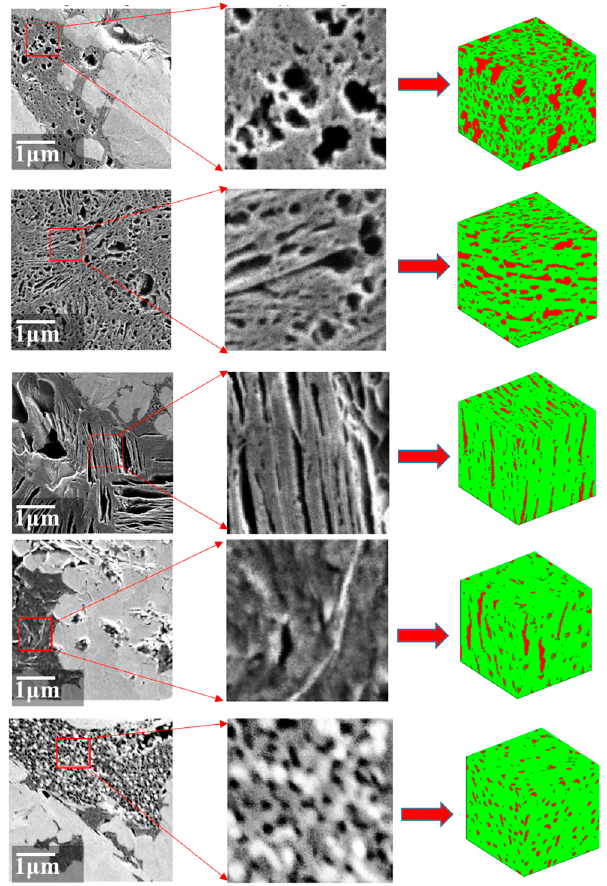
Figure 16. Pore structure of organic